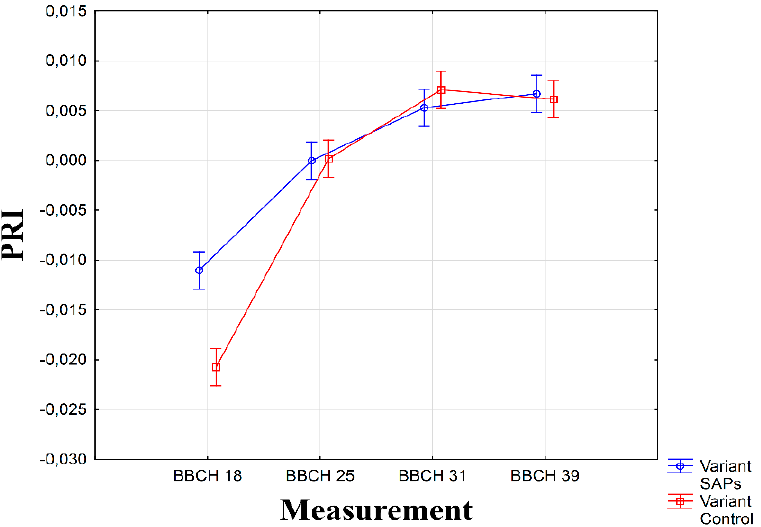
Figure 5. Interaction between experimental treatments and measurements for photochemical re- flectance index (PRI). Figure was obtained at level of significance α = 0.01.